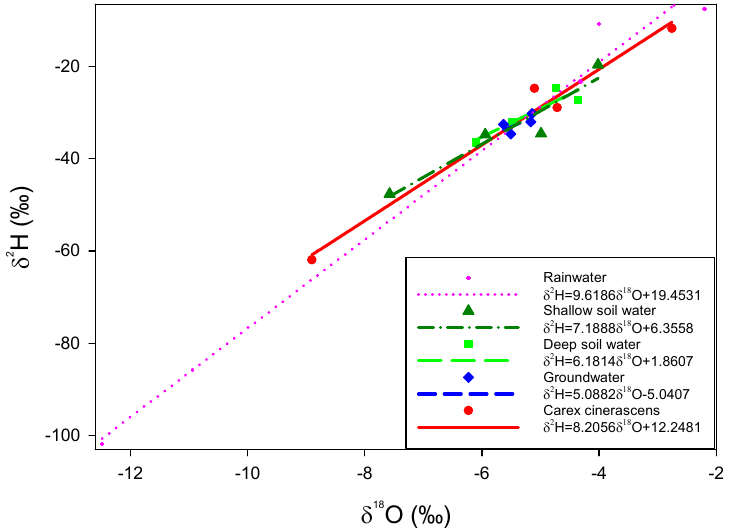
Figure 7. In the legend, each line is fitted by the points above it. Each point plotted is an average of several data in the same stage and each line is fitted through four stages about one sort of